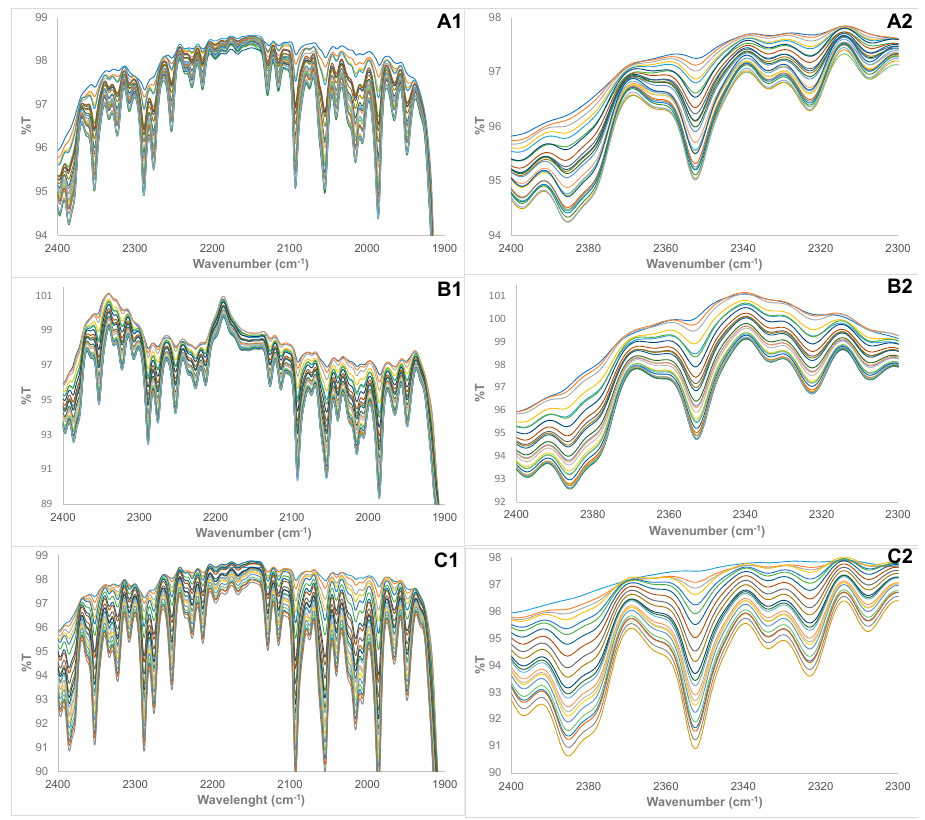
Figure 4. Cross section of FTIR spectra of validation samples of the following: ( A1 , A2 ) HRPO adulterated with vegetable oil, ( B1 , B2 ) HRPO adulterated with canola oil, ( C1 , C2 ) HRPO adulterated with almond oil. Table 2. Validation conducted for highly refined peanut oil (HRPO) adulterated with vegetable oil (VO).